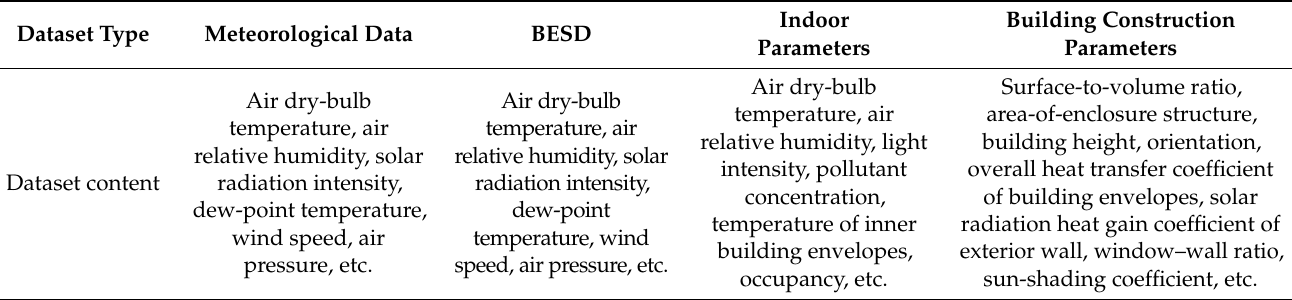
Table 1. Building energy consumption